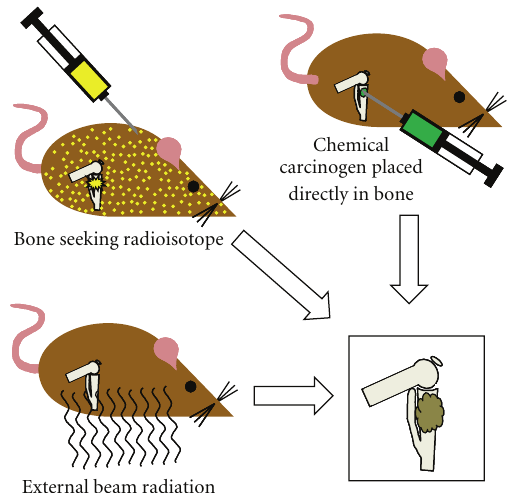
Figure 1: Osteosarcomagenesis can be induced in genetically wild-type mice through a variety of means. Most heavy metal radioisotopes will naturally home to ossifying bone matrix in the metabolically active metaphyses of long bones, emitting their radiation locally after embedding. External beam radiation in varied forms has also proven successfully osteosarcomagenic. Although a few chemical carcinogens administered systemically by oral or intravenous application in mice have proven su ffi cient, most osteosarcomagenic chemical compounds have been orthotopically implanted in the tibia or